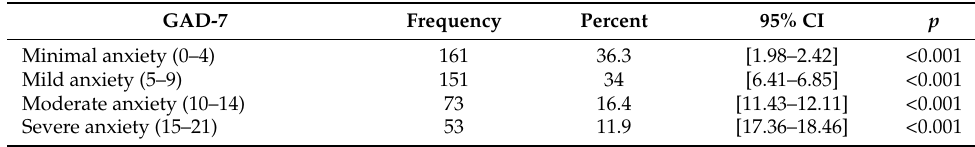
Table 3. The frequencies of the GAD-7 self-reported categories.